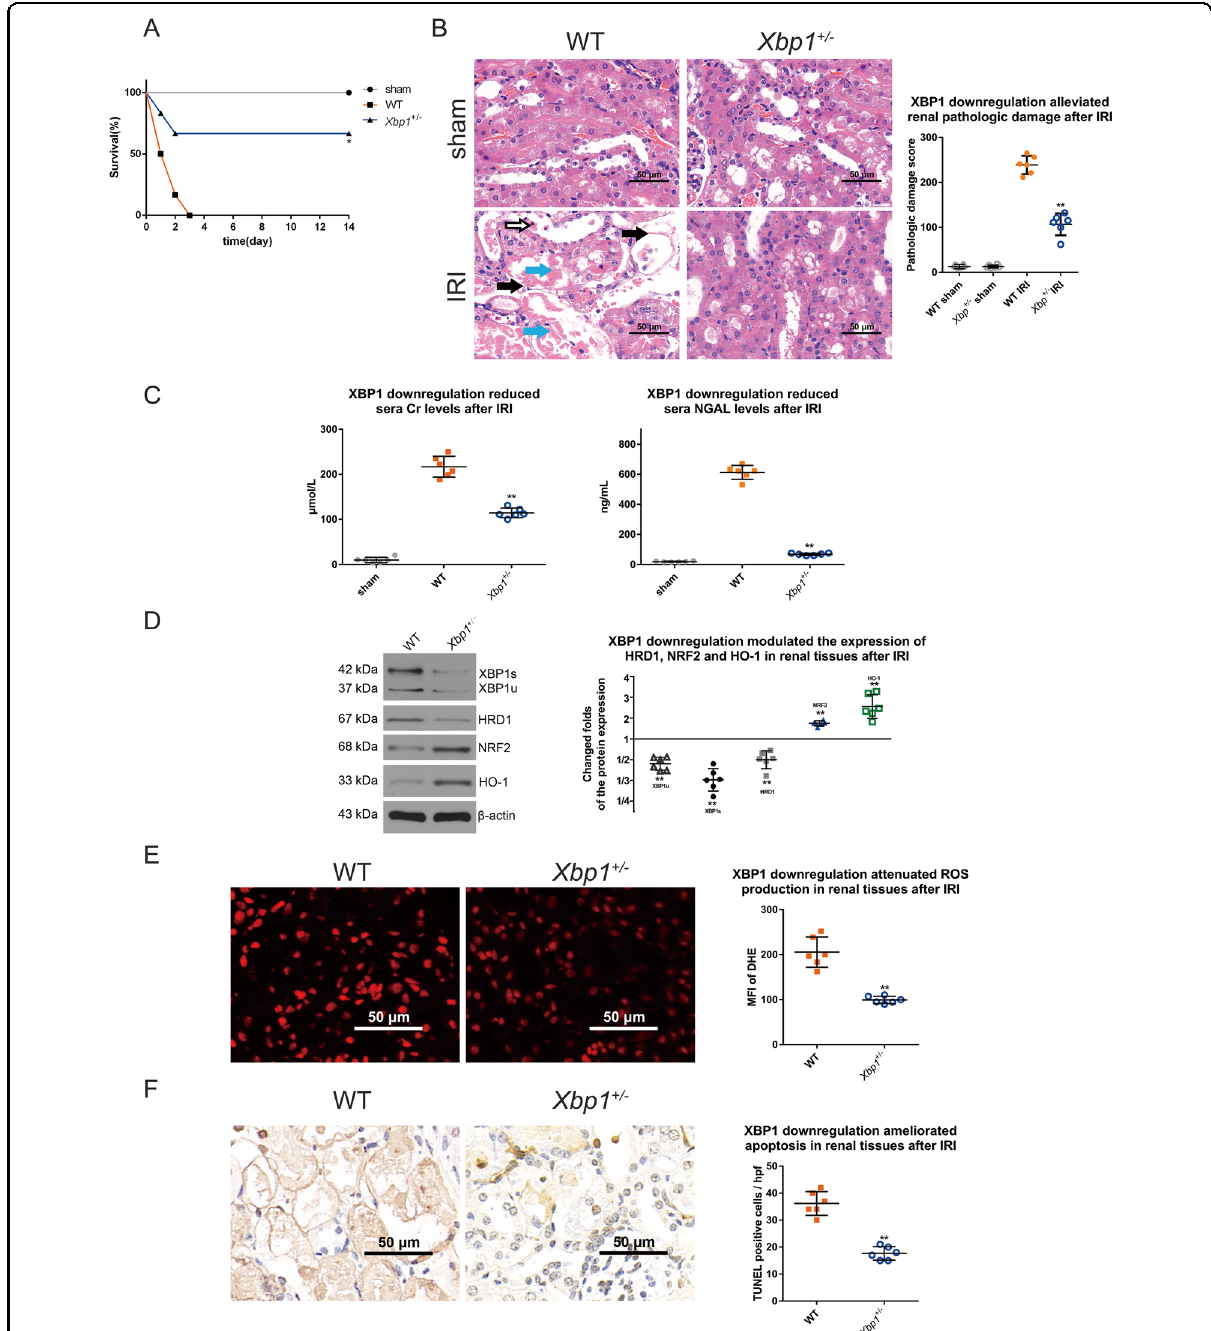
Fig. 2 Mice with reduced Xbp1 are resistant to IRI-induced AKI due to the enhanced expression of NRF2/HO-1 and diminished ROS in kidneys. A XBP1 downregulation signi fi cantly prolonged the survival of Xbp1 + / − mice. * P < 0.05 vs. IRI group ( n = 6). B XBP1 downregulation signi fi cantly alleviated acute renal damage and decreased pathological damage scores. H&E staining; scale bar = 50 μ m, ×400 magni fi cation. ** P < 0.01 vs. IRI group ( n = 6). Tubular necrosis is denoted by light blue arrows, sloughing of epithelial cells are represented by white arrows, and tubular basement membrane damage are indicated by black arrows. H&E staining; ×400 magni fi cation; scale bar = 50 μ m. ** P < 0.01 vs. the sham group ( n = 6). C XBP1 downregulation signi fi cantly reduced the sera levels of Cr and NGAL. ** P < 0.01 vs. IRI group ( n = 6). D XB P 1 downregulation signi fi cantly decreased the expression levels of XBP1 and HRD1, while increased the expression levels of NRF2 and HO-1. Western blot; ** P < 0.01 vs. IRI group ( n = 6). E IR-induced ROS production was signi fi cantly attenuated in the kidneys of Xbp1 + / − mice, as shown by both MFI of DHE. Scale bar = 50 μ m; ×400 magni fi cation. ** P < 0.01 vs. IRI group ( n = 6). F XBP1 downregulation signi fi cantly reduced the number of apoptotic cells. TUNEL assay; scale bar = 50 μ m, ×400 magni fi cation. ** P < 0.01 vs. IRI group ( n =